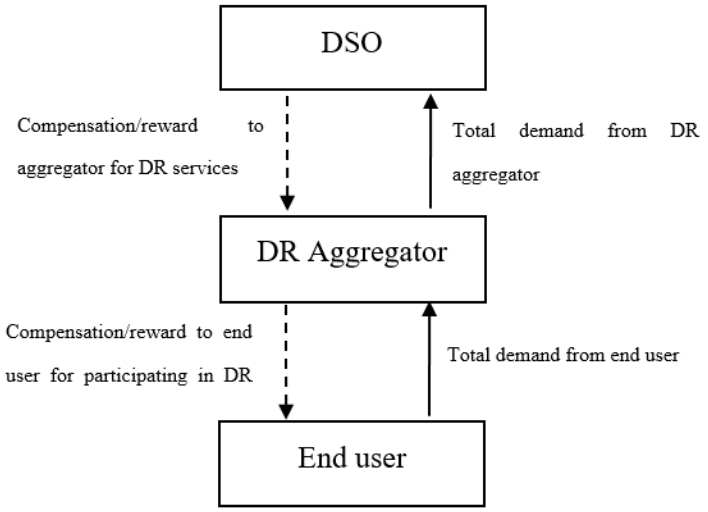
Figure 1. Role of the aggregator in connecting a distribution service operator (DSO) and end users in a cluster.